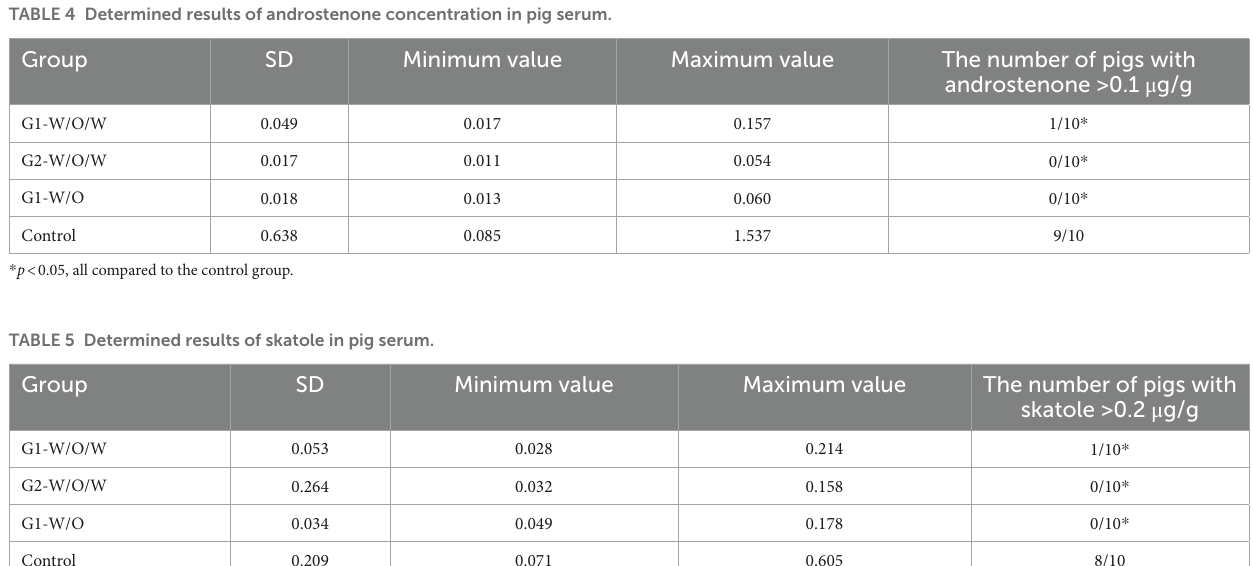
TABLE 4 Determined results of androstenone concentration in pig serum. Group